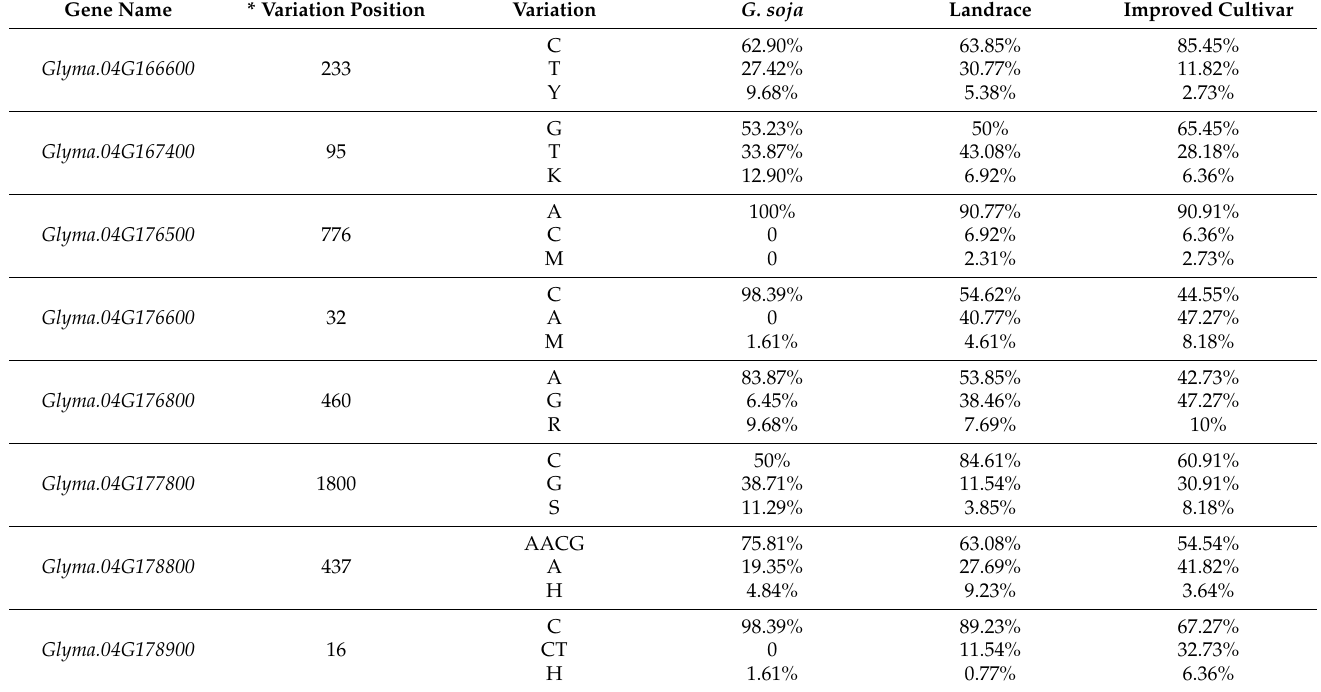
Table 4. Variation information and percentage of the eight genes in the